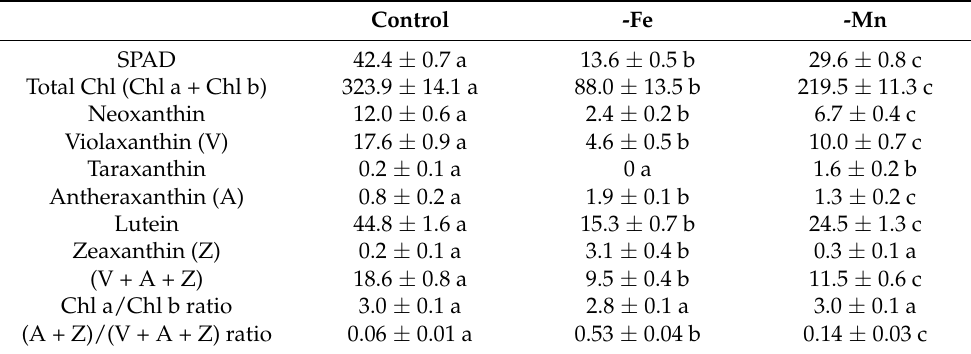
Table 1. SPAD values, concentrations of photosynthetic pigments (in µ mol m − 2 ) and pigment ratios in young, expanded leaves of tomato plants grown in control, Fe deficiency, and Mn deficiency conditions. Data are means ± SE ( n = 15 plants). Different letters in the same row indicate statistically significant differences (Student’s t -test, p ≤